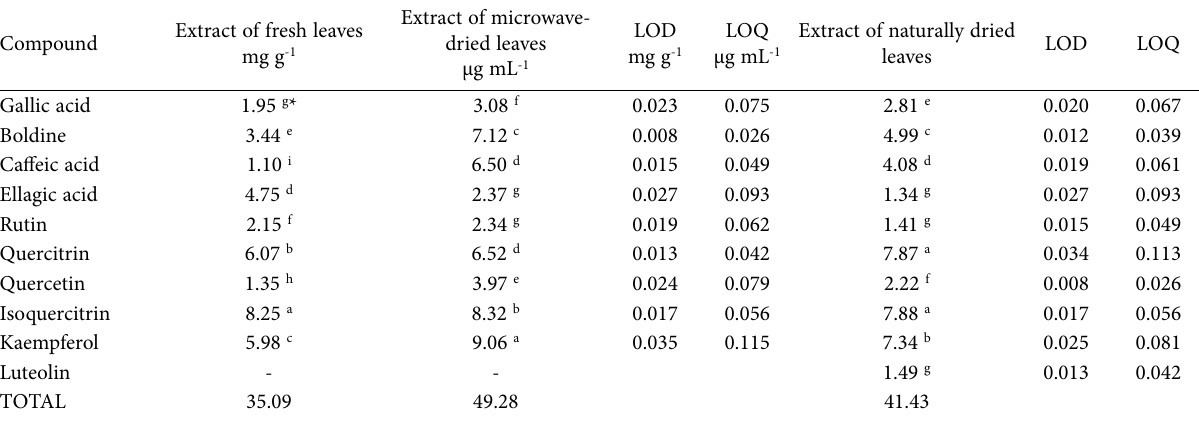
Table 4. Phenolic compounds in aqueous extracts by decoction of Plectranthus barbatus stems using high performance liquid chromatogra- phy